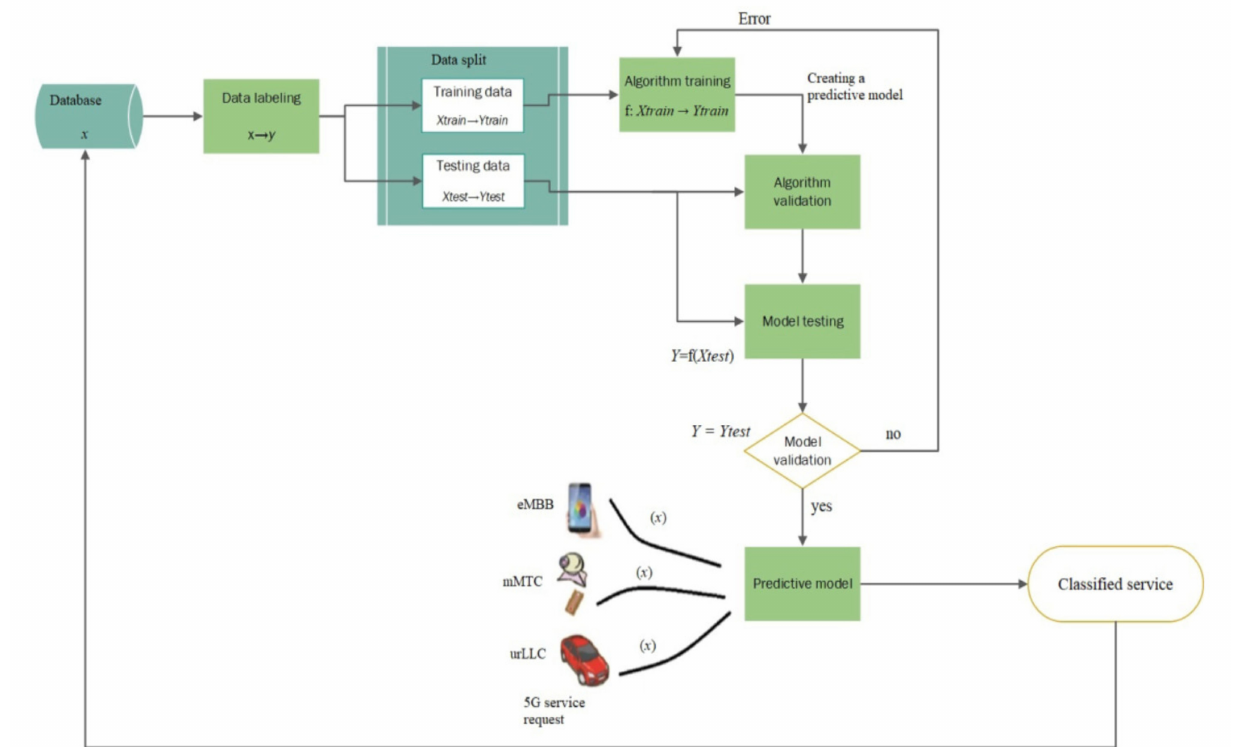
Figure 1. Schematic diagram of the proposed 5G/B5G service